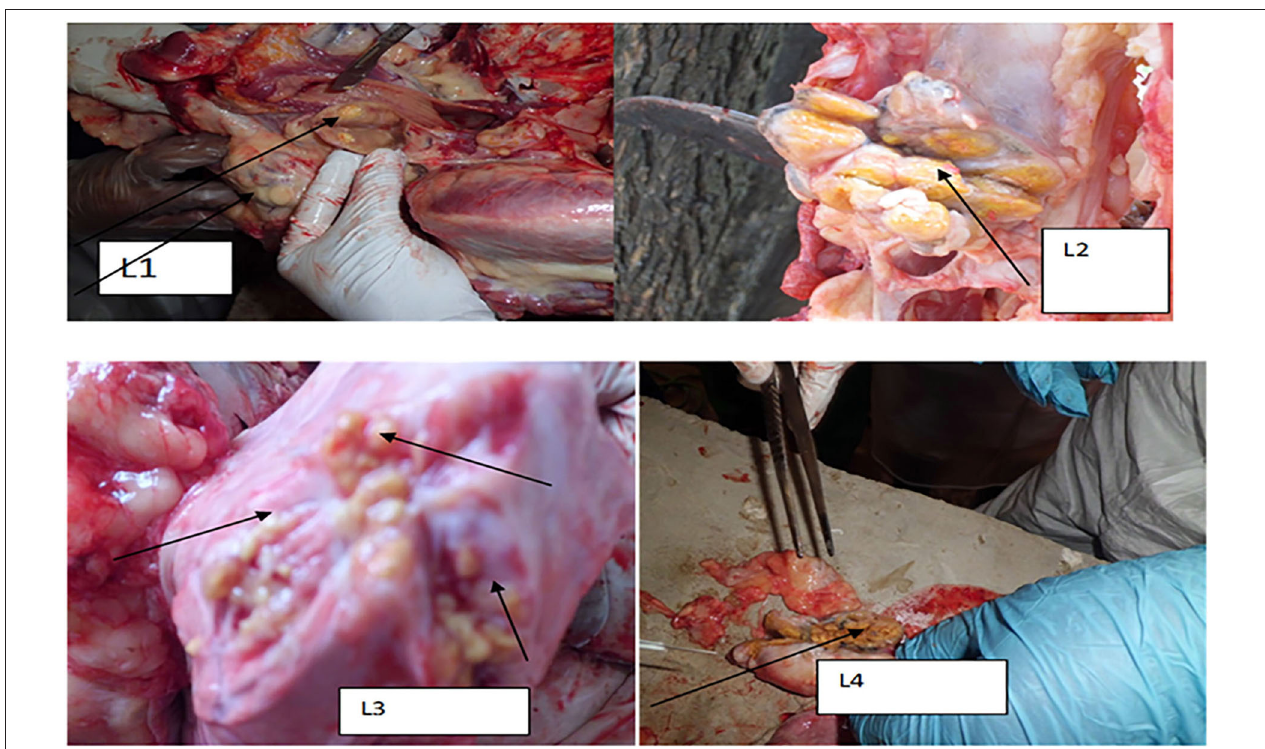
FIGURE 1 | Typical TB lesions obtained in the lymph nodes and lung lobs of selected dairy cattle in central Ethiopia. L1: TB lesion on retropharyngeal lymph node; L2: disseminated TB lesions on bronchial lymph node indicated by the arrow; L3: TB lesions on the diaphragmatic lobe of the lung; and L4: calcified lesion from the mesenteric lymph node.